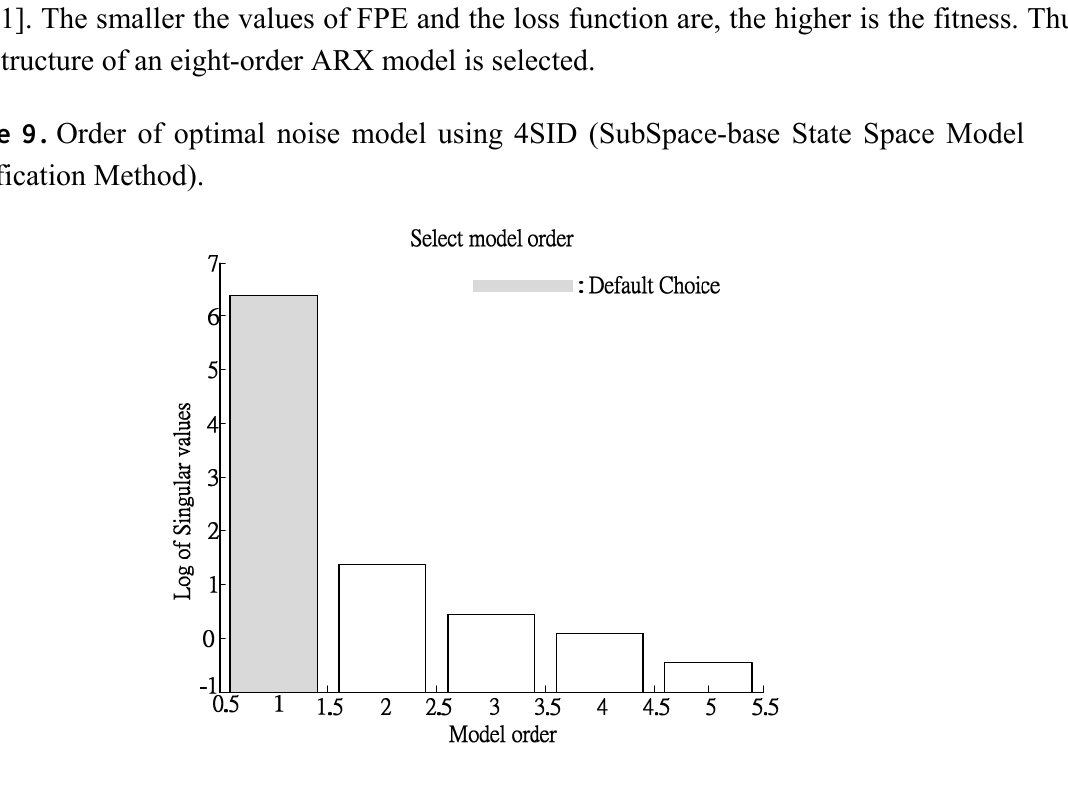
Table 7. Identification results from the